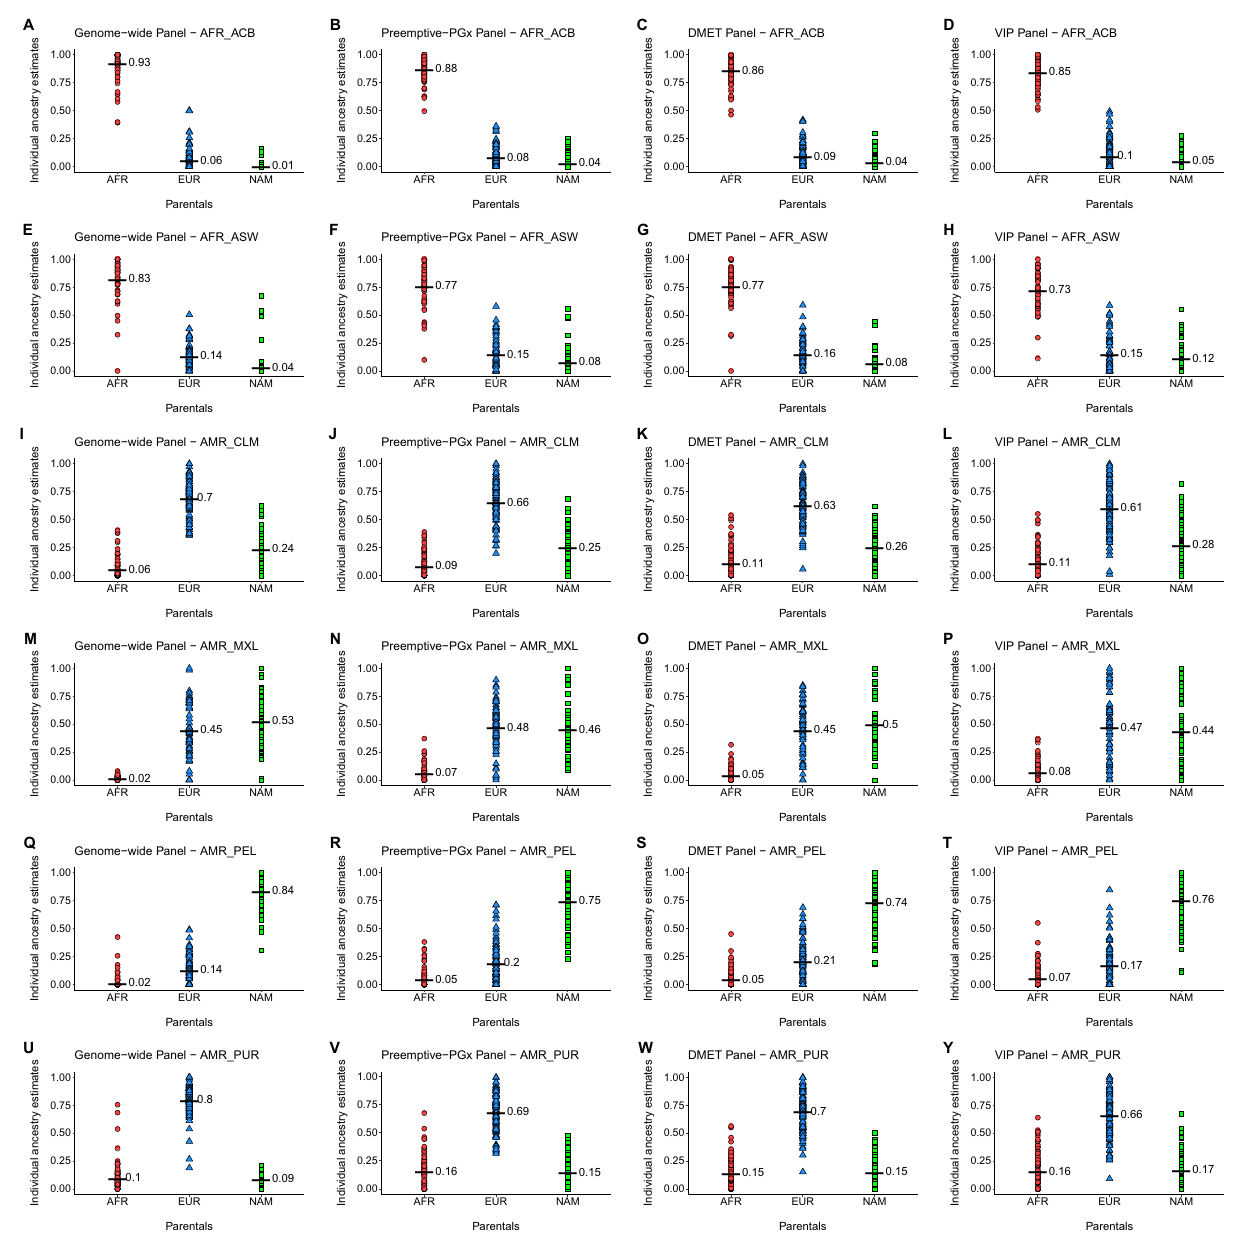
Figure 2. Individual estimates of the admixed populations for each ancestry with Genome-wide, Preemptive- PGx, DMET and VIP panels. ( A – D ) AFR_ACB; ( E – H ) AFR_ASW; ( I – L ) AMR_CLM; ( M – P )